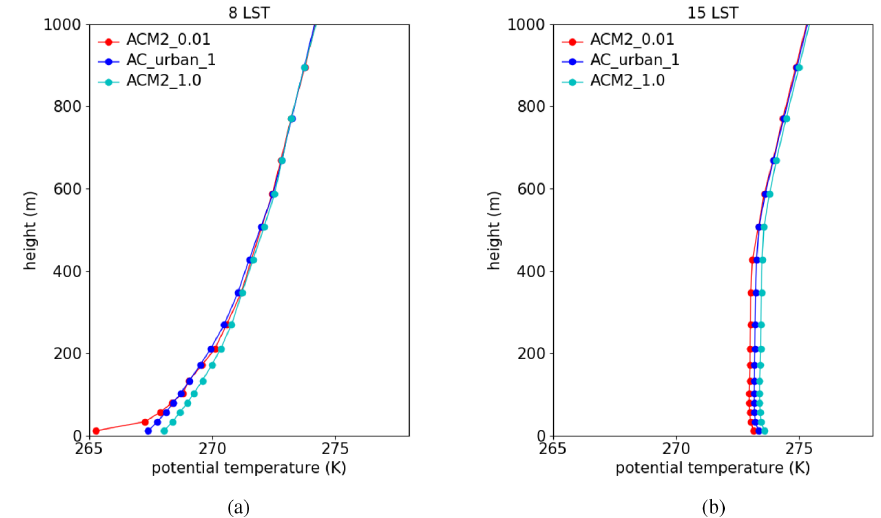
Figure 7. The vertical profiles of the potential temperature predicted by ACM2_0.01, AC_urban_1, and ACM2_1.0 at (a) 08:00LST and (b) 15:00LST averaged over the simulated